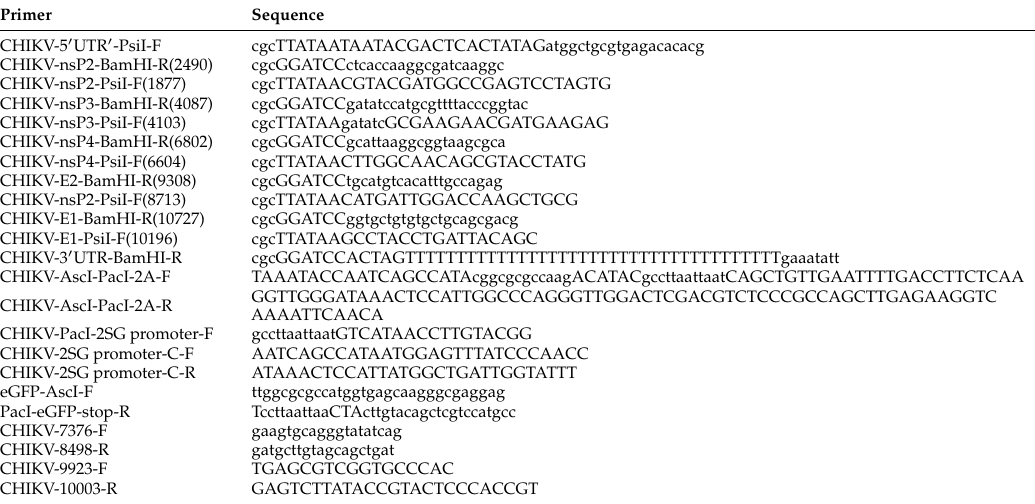
Figure 1. Isolation and characterization of CHIKV from clinical human cases. ( a ) the flow chart of virus isolation on C6/36 cells from human serum; ( b ) the CHIKV strain that was passaged for seven rounds on C6/36 cells showed apparent CPE on BHK-21 cells; ( c ) plaque morphology of the CHIKV strain on BHK-21 cells on the four days post-inoculation; and ( d ) phylogenetic analyses of CHIKV genome sequences using the neighbor-joining method. The newly isolated CHIKV strain is highlighted in red. ECSA lineage = the East, Central and South African lineage. Table 1. Primer